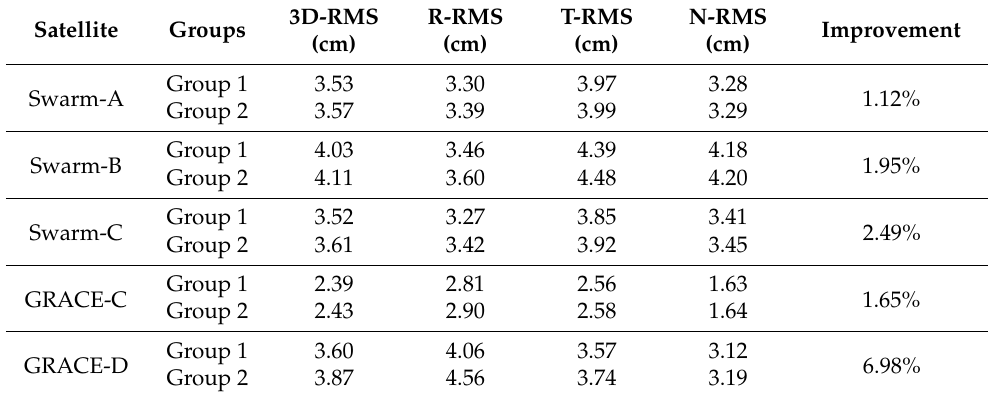
Table 5. RMS with different groups comparing kinematic orbit and reference